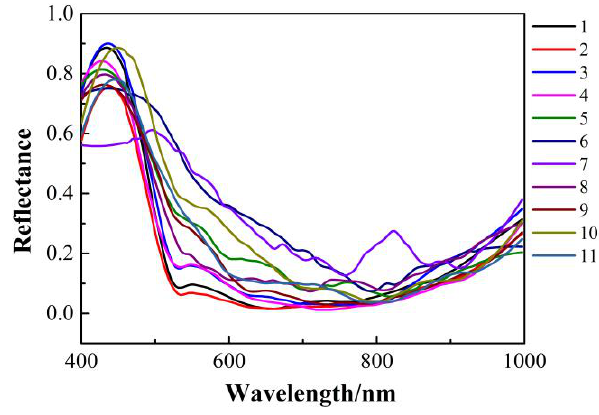
Figure 14. Spectra of the Class 6 in active HSI data. A total of 11 spectra are randomly selected.